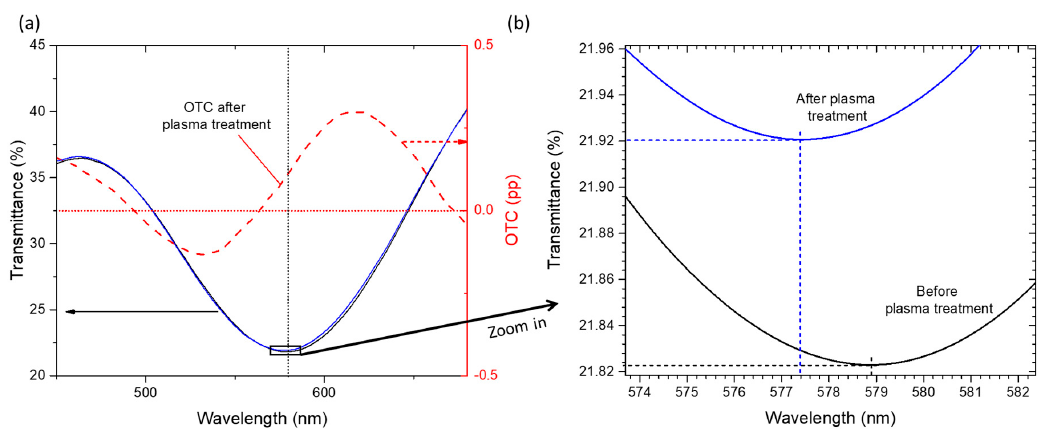
Transmittance Change (OTC); ( b ) Zoom of the spectra showing a blueshift of the LSPR peak of 1.5